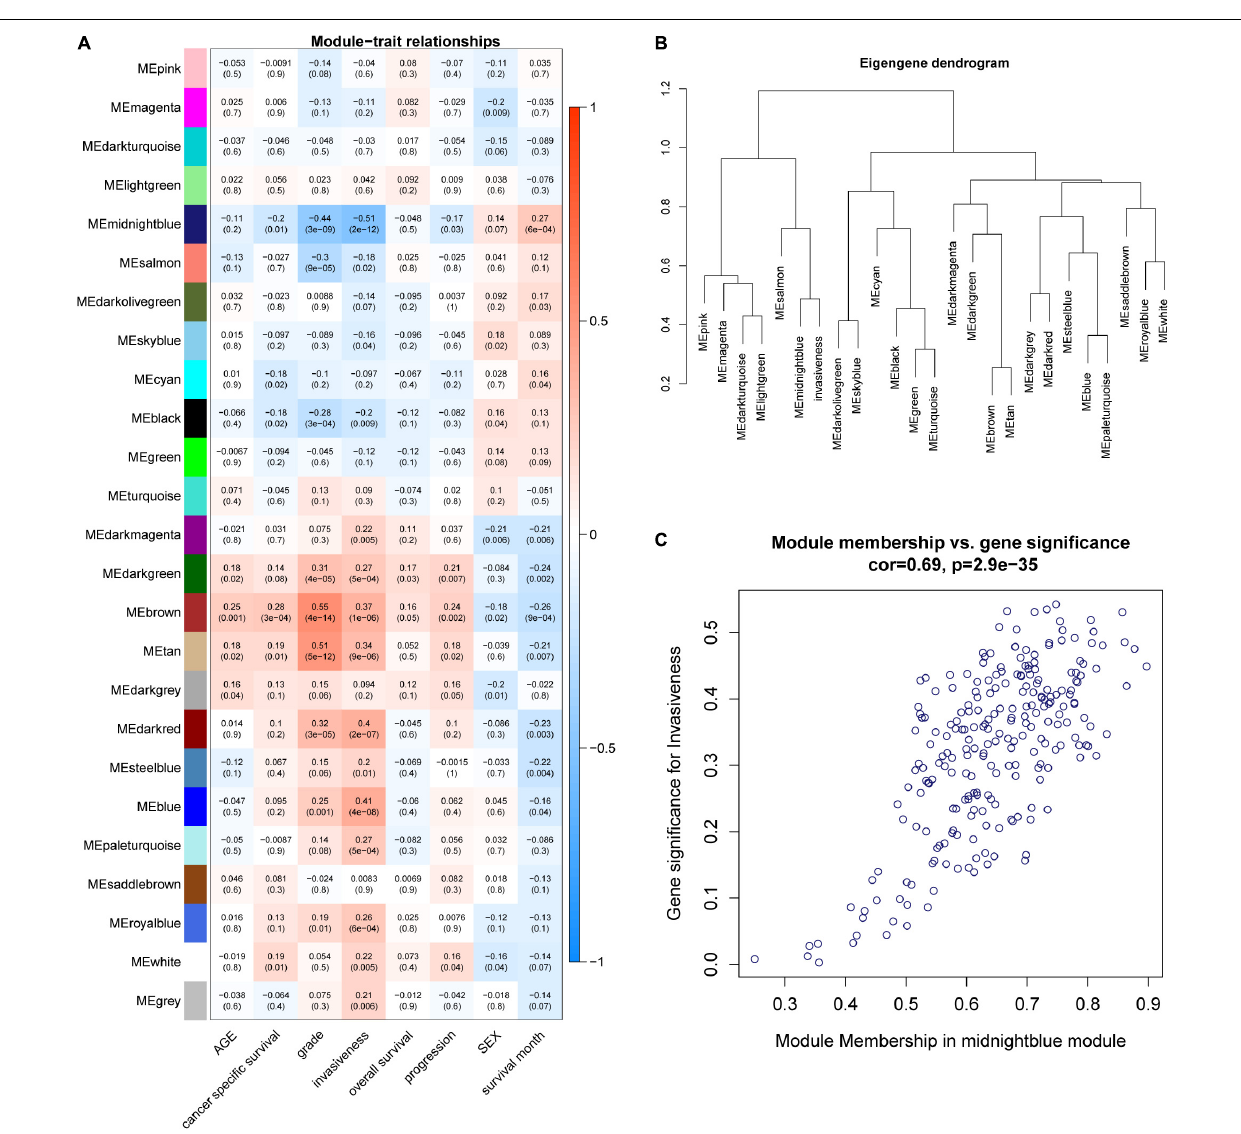
FIGURE 4 | (A) A heatmap was created to display the relationships between modules and traits; correlation coefficients and P -values are also shown for each module. (B) Invasiveness was integrated into the eigengene network to explore the connection between the trait and modules. (C) Correlation between module membership (MM) and gene significance